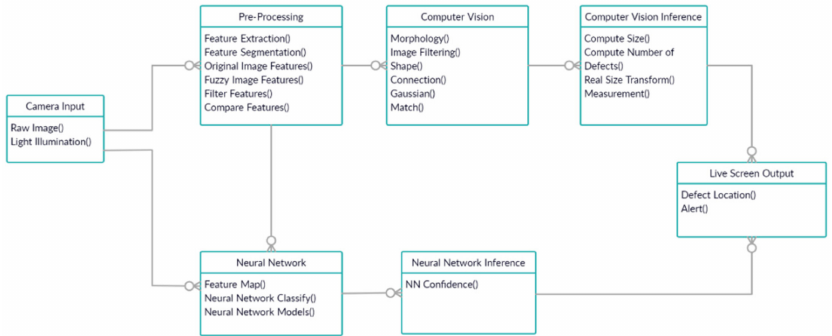
Figure 5. Functional